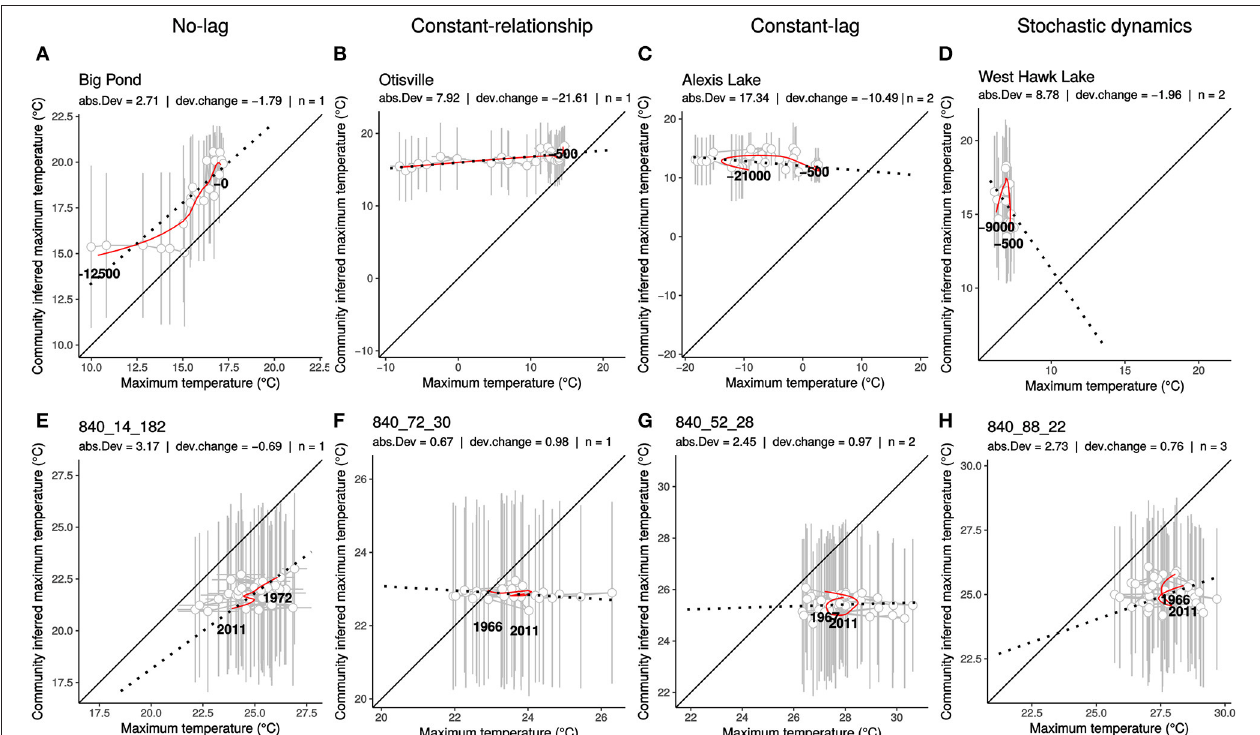
FIGURE 2 | Examples of representative community response diagrams (CRD). Representative CRD from plant community responses during Late Quaternary climate change (top, A–D ) and birds community responses between 1966 and 2011 (C,E) (bottom, E–H ). For each CRD, community-inferred maximum temperature (y-axis) is plotted over observed maximum temperature in a time-implicit diagram. Gray points and bars are raw mean values with associated standard deviations. Red lines are smoothed values used to compute statistics. Black lines are 1:1 relationship, dotted black lines represent the linear regression of the smoothed values. Name of the site and summary statistics are reported at the top of each panel, abs.Dev = absolute deviation ¯ 3 , dev.change = deviation change d 3 , n = maximum state number n